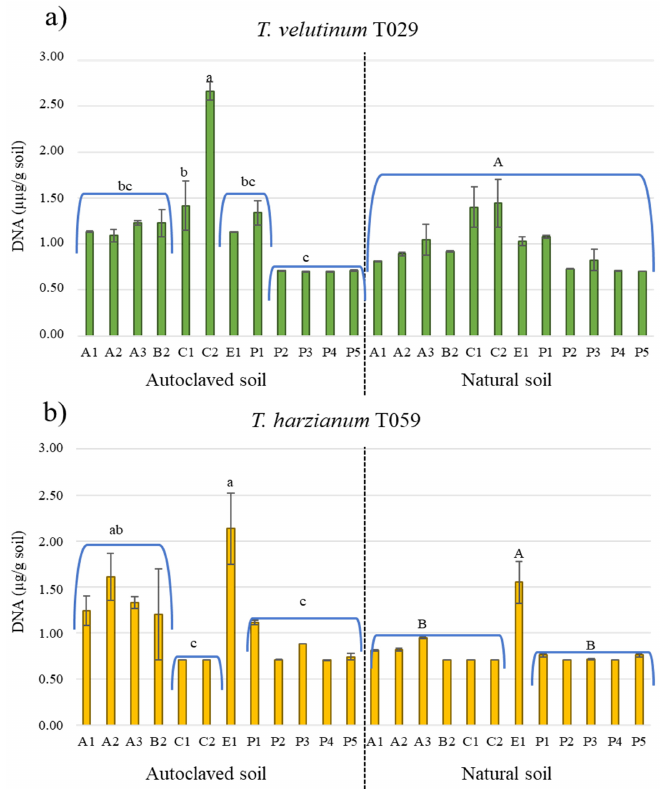
Figure 2. DNA concentration ( µ g · g soil − 1 ) of T. velutinum T029 ( a ) and T. harzianum T059 ( b ) development in different soil samples after 15 days. Left: Autoclaved soil: soil sample autoclaved to 121 °C 20 min. Right: Natural soil, soil sample not autoclaved. Upper and lower error bars are represented and indicated standard error of the mean showing the accuracy of the calculations. Differences statistically significant (Tukey’s test p < 0.05) are indicated with different letters; capital letter are differences in natural soils (NS) and small letter are differences between autoclaved soils (AS). The code of each soil is detailed in Table 1.